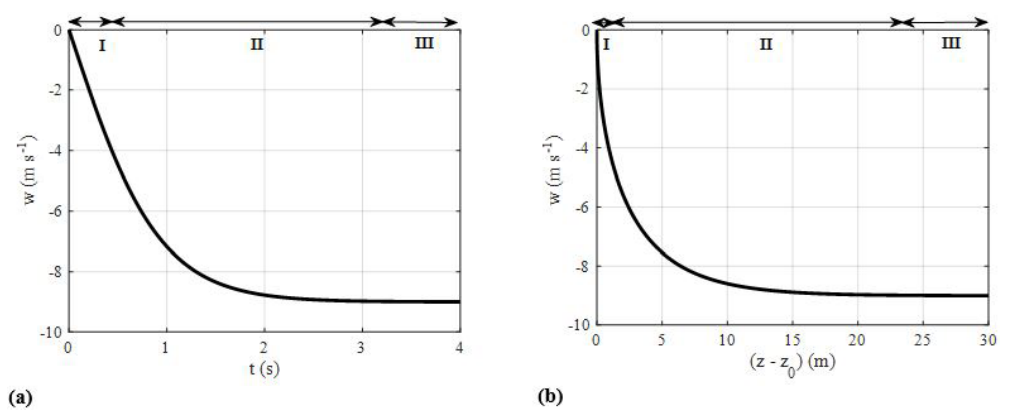
Figure 2. (a) Ballistics fall curves illustrating three fall phases (I, II, and III) and (b) velocity variation with position relative to the drop height z 0